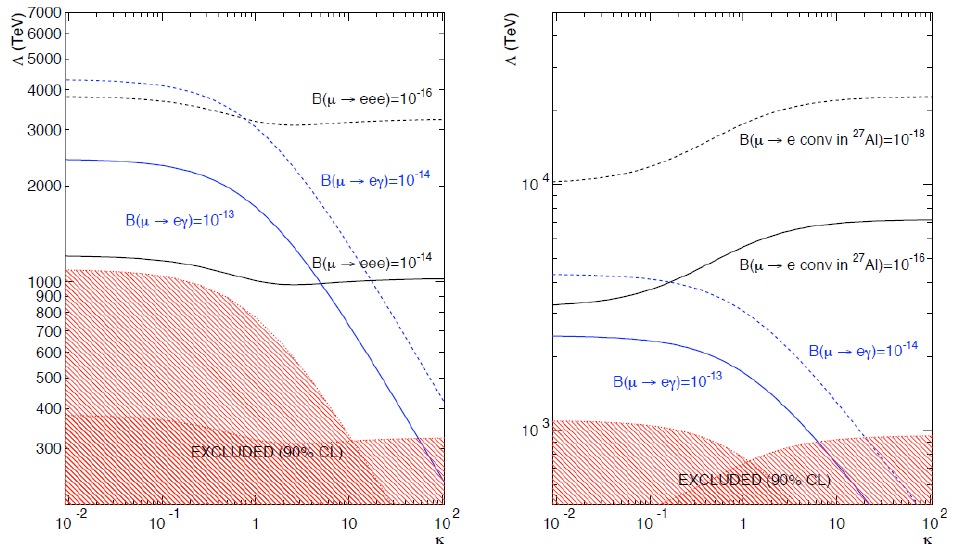
Figure 2: Reach for new physics in terms of an effective mass scale Λ in µ → e γ and µ → eee decays (left) and µ → e conversions (right) [ 1 ] for different experimental sensitivities. κ is a parameter that weights the relative strength of dipole type contri- butions to four-fermion contact interactions and strictly speaking only κ = 0 (dipole int.) and κ → ∞ (contact int.) are of interest, since it is very unlikely that different mechanisms will contribute at similar scales. The reach of the µ → eee decay (left) for dipole type interactions ( κ → 0) could be significantly increased, if the process is mediated by the exchange of a Z boson instead of a